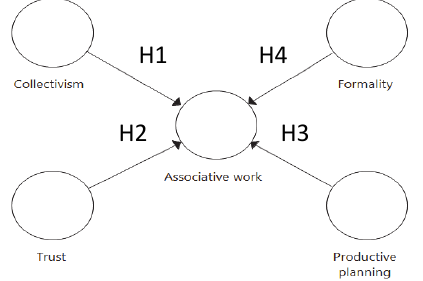
Fig. 1. Conceptual model and